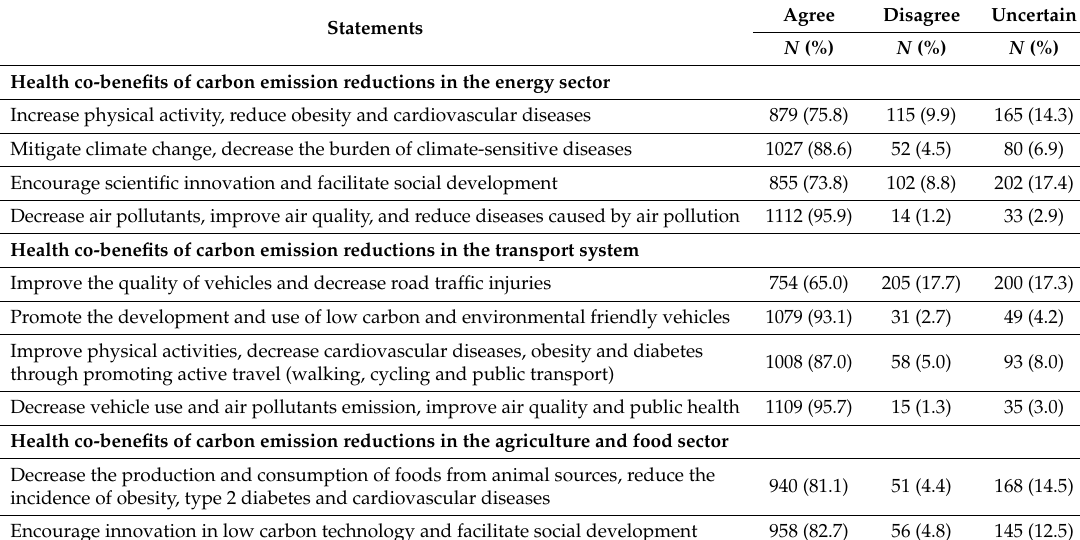
Table 4. Perceptions of respondents on the health co-benefits in relation to GHG mitigation measures in different economic or social